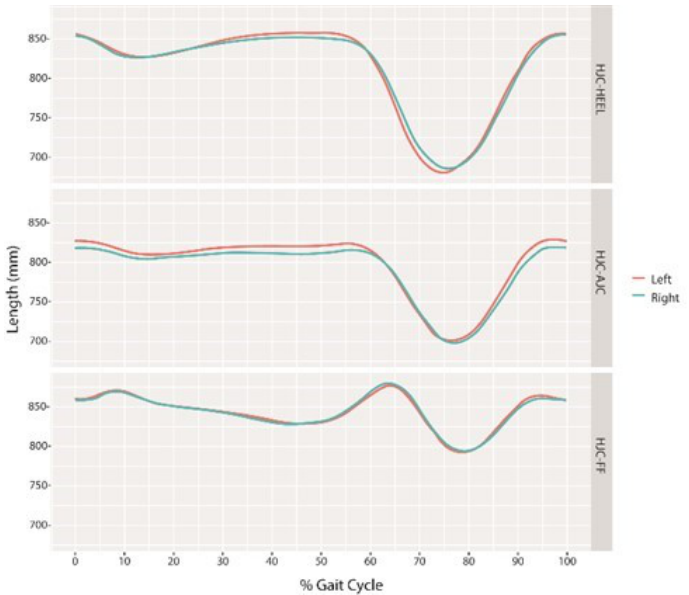
Figure 4. Average and standard deviation DLLs of one sampled subject as measured from the HJC to